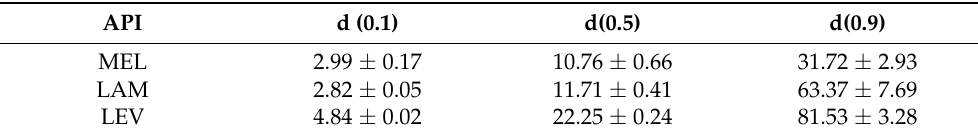
Table 2. Size distribution of the APIs (μm).